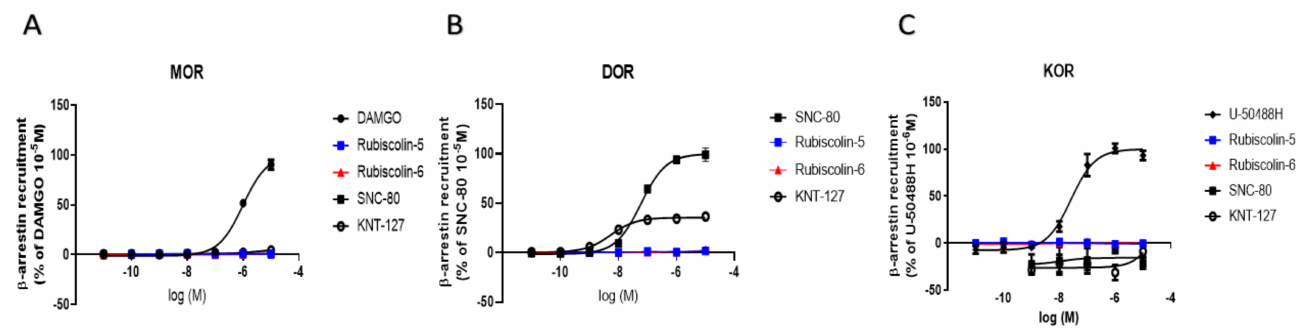
Figure 5. Levels of β -arrestin recruitment through OR induced by rubiscolin-5, rubiscolin-6, and opioid compounds. PathHunter ® β -arrestin assay was performed in cells expressing MOR ( A ), DOR ( B ), and KOR ( C ) by treating with each compound (10 − 11 –10 − 5 M). Concentration–response curves were prepared by calculating intracellular β -arrestin levels relative to the data obtained for each positive control: 10 − 5 M DAMGO for MOR ( A ), 10 − 5 M SNC-80 for DOR ( B ), and 10 − 6 M of U-50488H for KOR ( C ). All data points are presented as means ± S.E.M. for three independent experiments ( n =